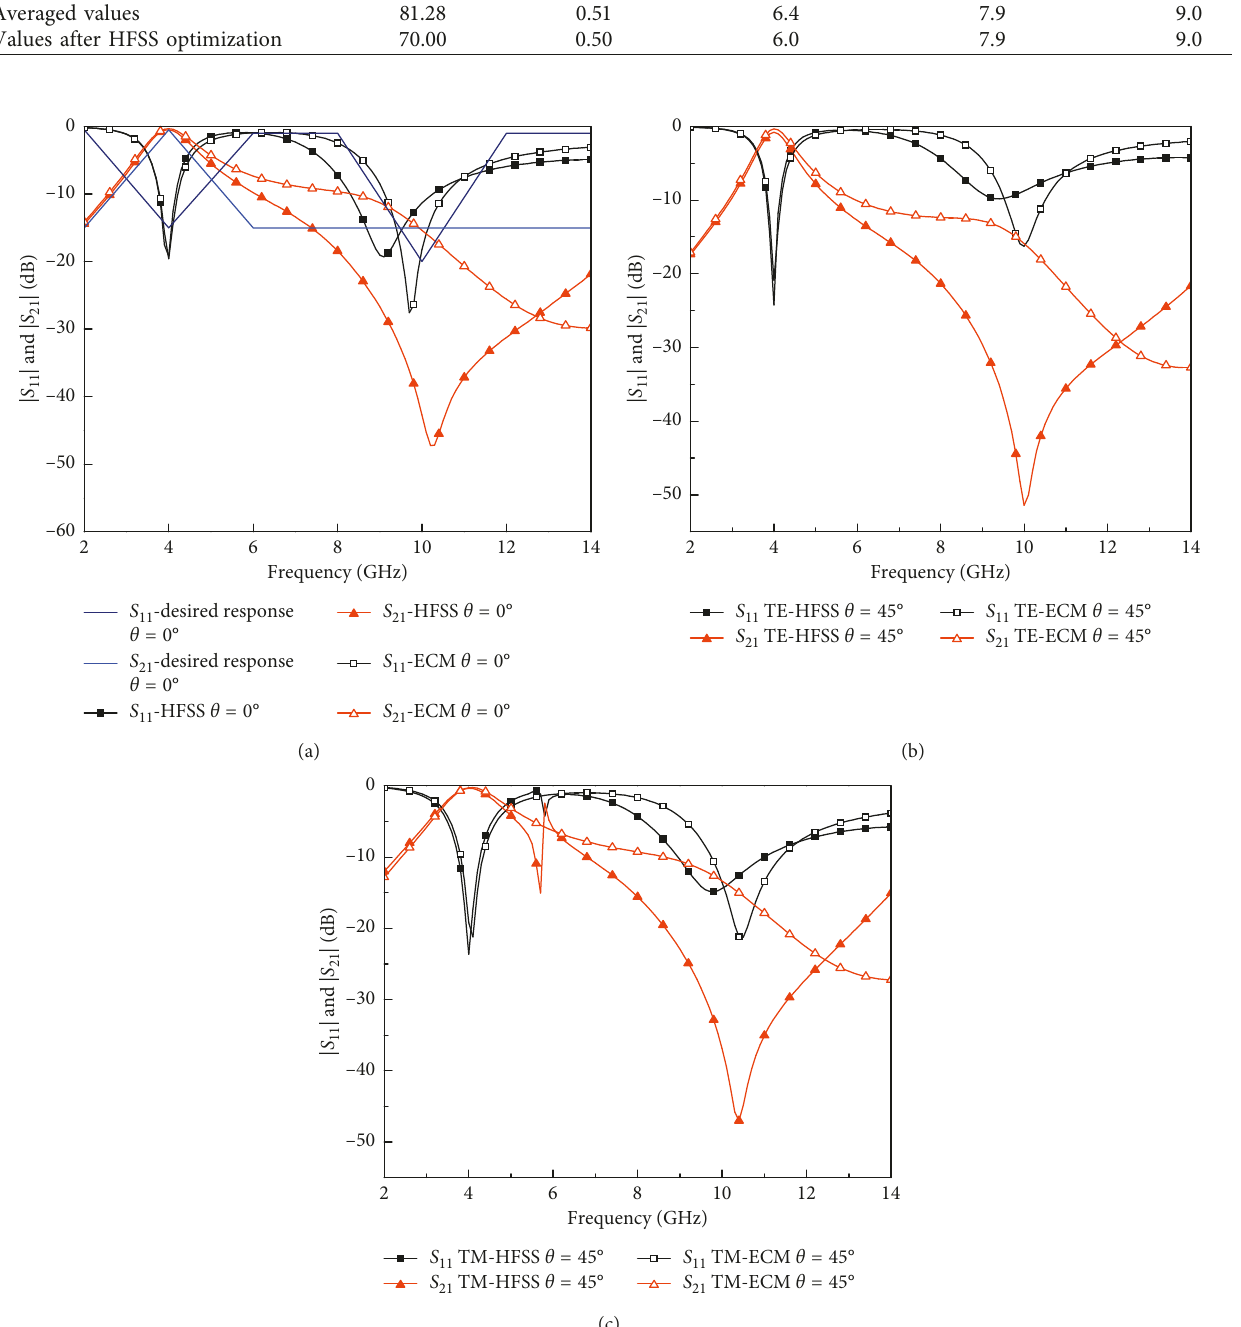
Figure 10: Simulated | S | and | S | using the ECM and HFSS. (a) Normal incidence. (b) Oblique incidence at θ � 45 ° for TE polarization. 11 21 (c) Oblique incidence at θ � 45 ° for TM polarization.